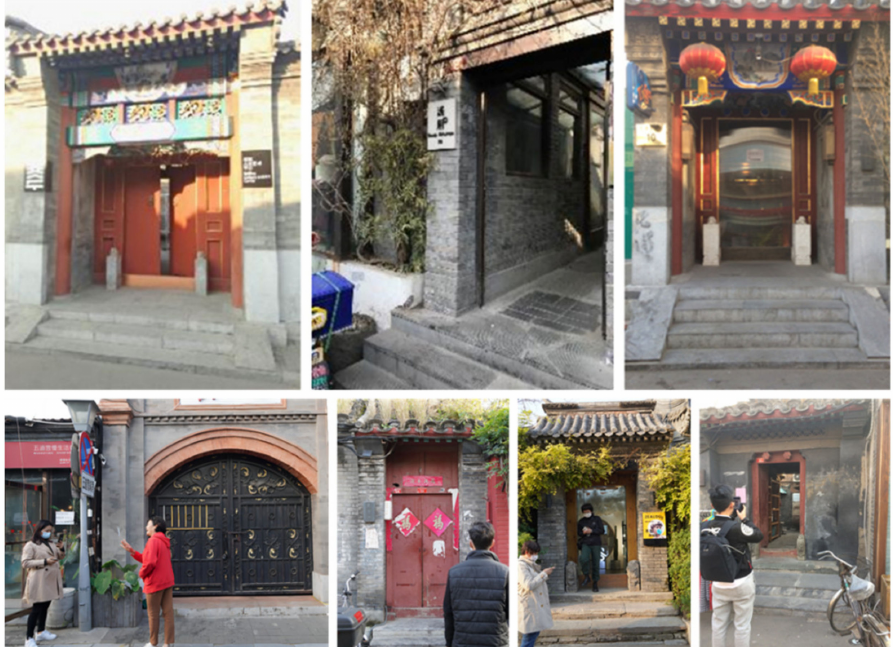
Figure 8. Typical Chinese building units and corresponding tourists’ walking-stopping behaviors in Wudaoying